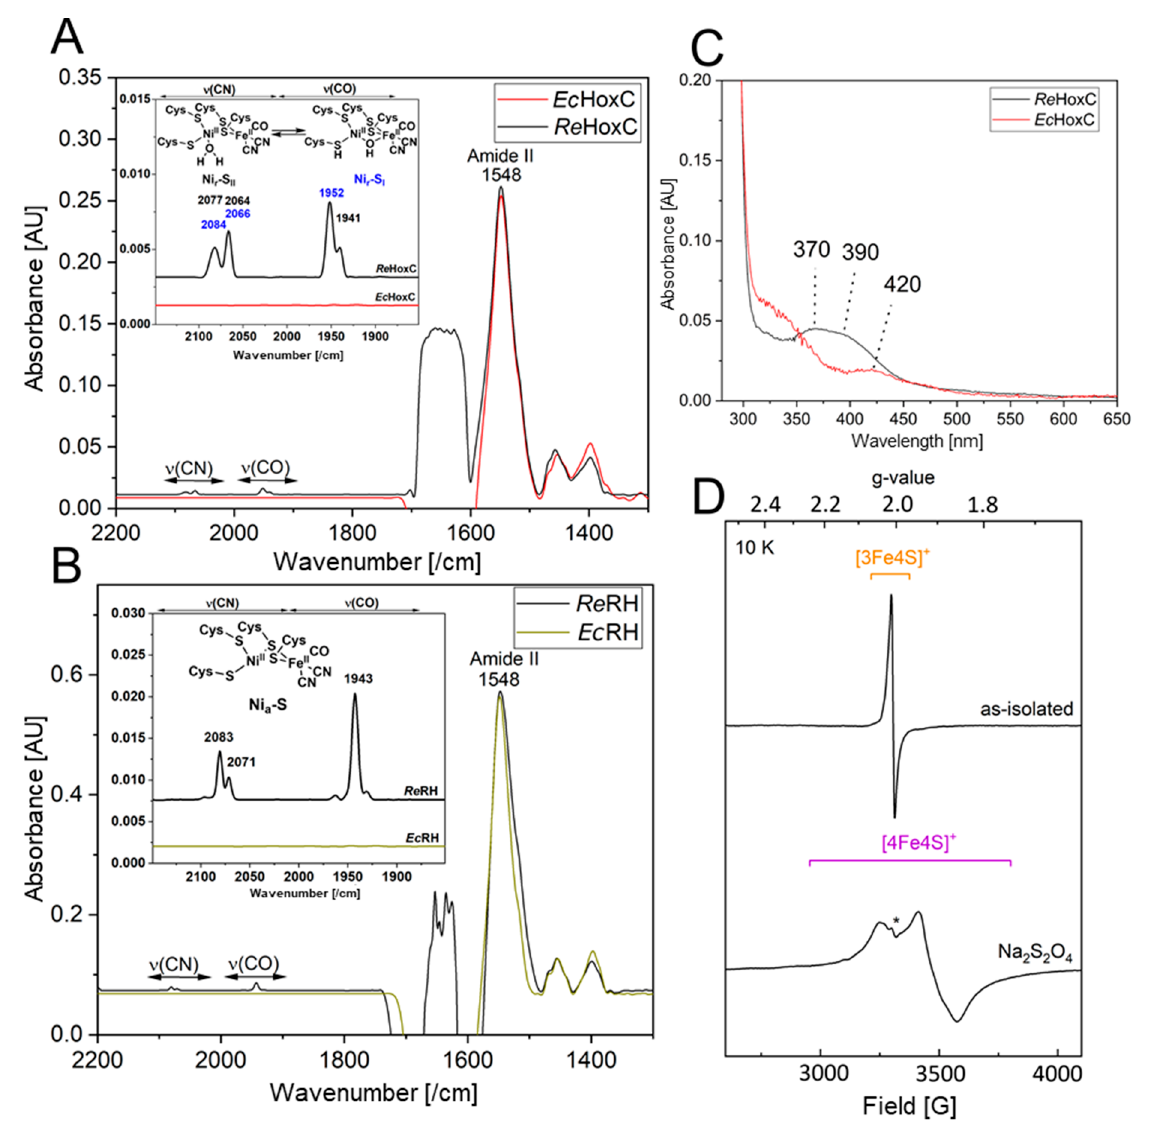
Figure 7. Comparative spectroscopic characterization of RH and isolated HoxC purified from R. eutropha and E. coli . ( A ) Comparison of IR spectra of as-isolated HoxC produced from E. coli ( Ec HoxC, red line) and R. eutropha ( Re HoxC, black line). ( B ) Comparison of IR spectra of as-isolated RH stop produced from E. coli (dark yellow line) and R. eutropha (black line). ( C ) Comparison of UV-vis absorption spectra of 20 µM as-isolated HoxC produced from E. coli (red line) and R. eutropha (black line). The spectrum of E. coli -derived HoxC shows only minor absorptions around 420 nm, probably related to heme-containing protein contaminants copurified with the large subunit. HoxC from R. eutropha shows active site contributions characterized by two absorption bands at 370 and 390 nm [14]. ( D ) EPR spectra recorded at 10 K with a microwave power of 1 mW of as-isolated RH stop (0.2 mM) from E. coli (top trace), containing minor contributions of a [3Fe–4S] + cluster species, in line with data recorded of native RH [34]. The bottom trace represents reduced RH stop treated with an